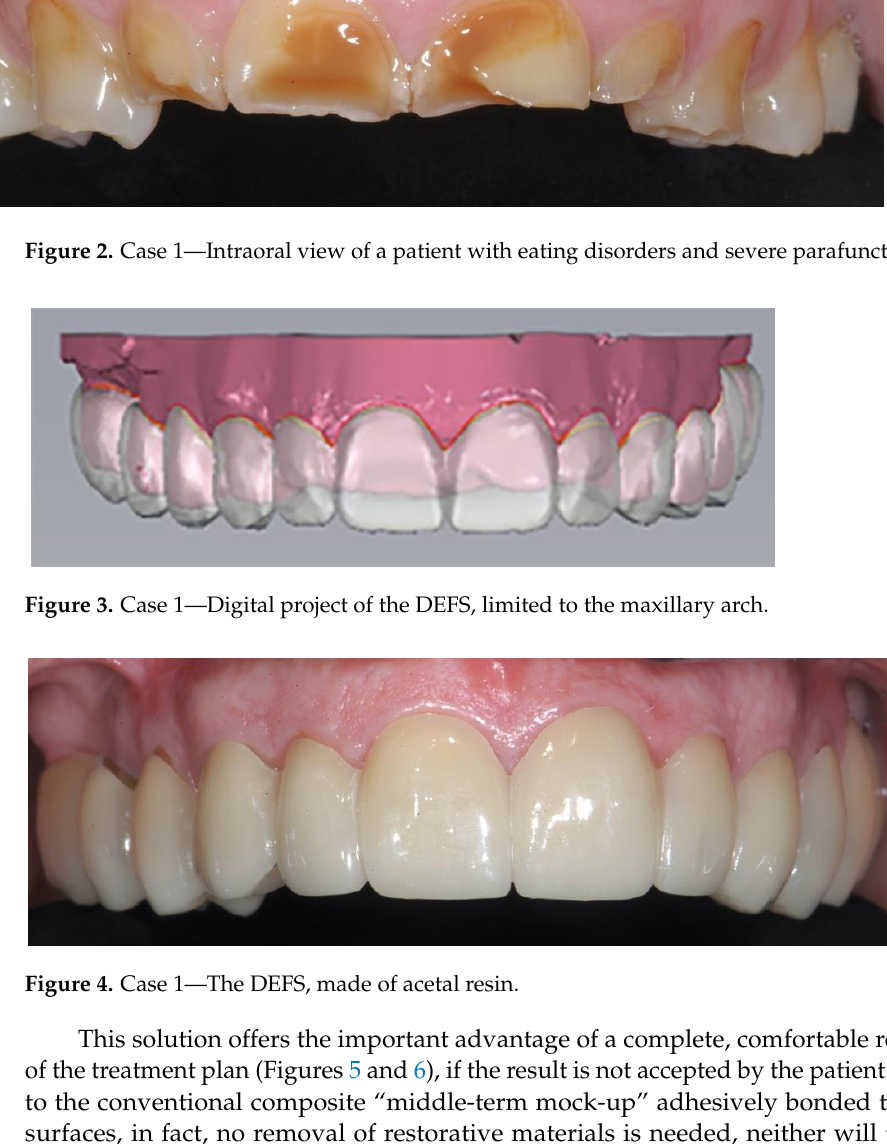
Figure 5. Case 2—Dental arches of a patient with parafunctions.